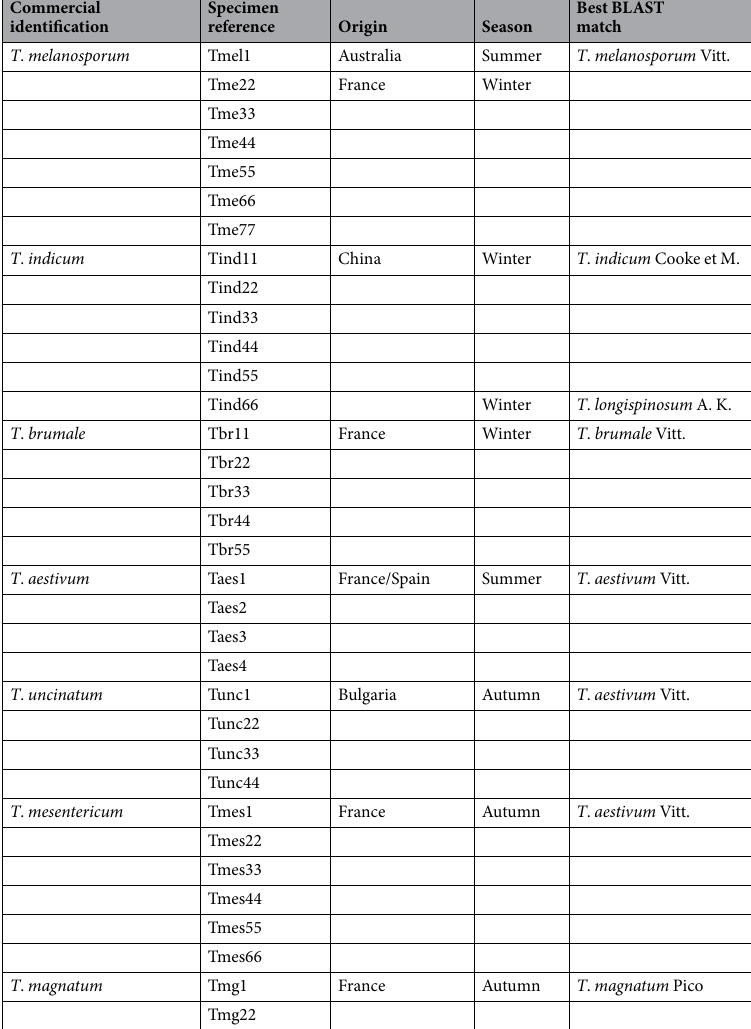
Table 1. List of the 34 commercial fresh truffles identified by BLAST homology of ITS